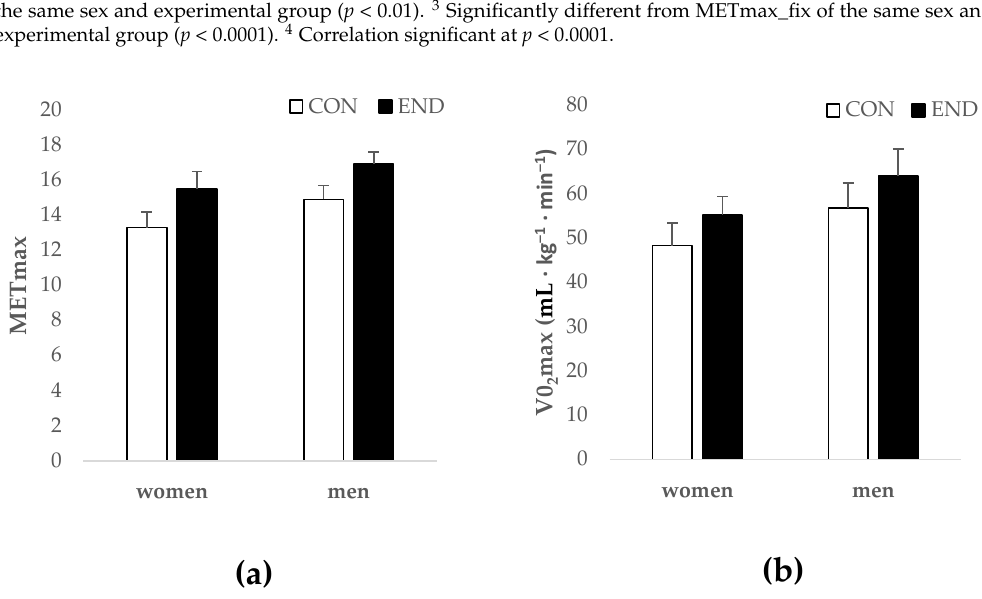
Table 3. Calculation of activity energy expenditure (AEE) for one hour of activity (either light,